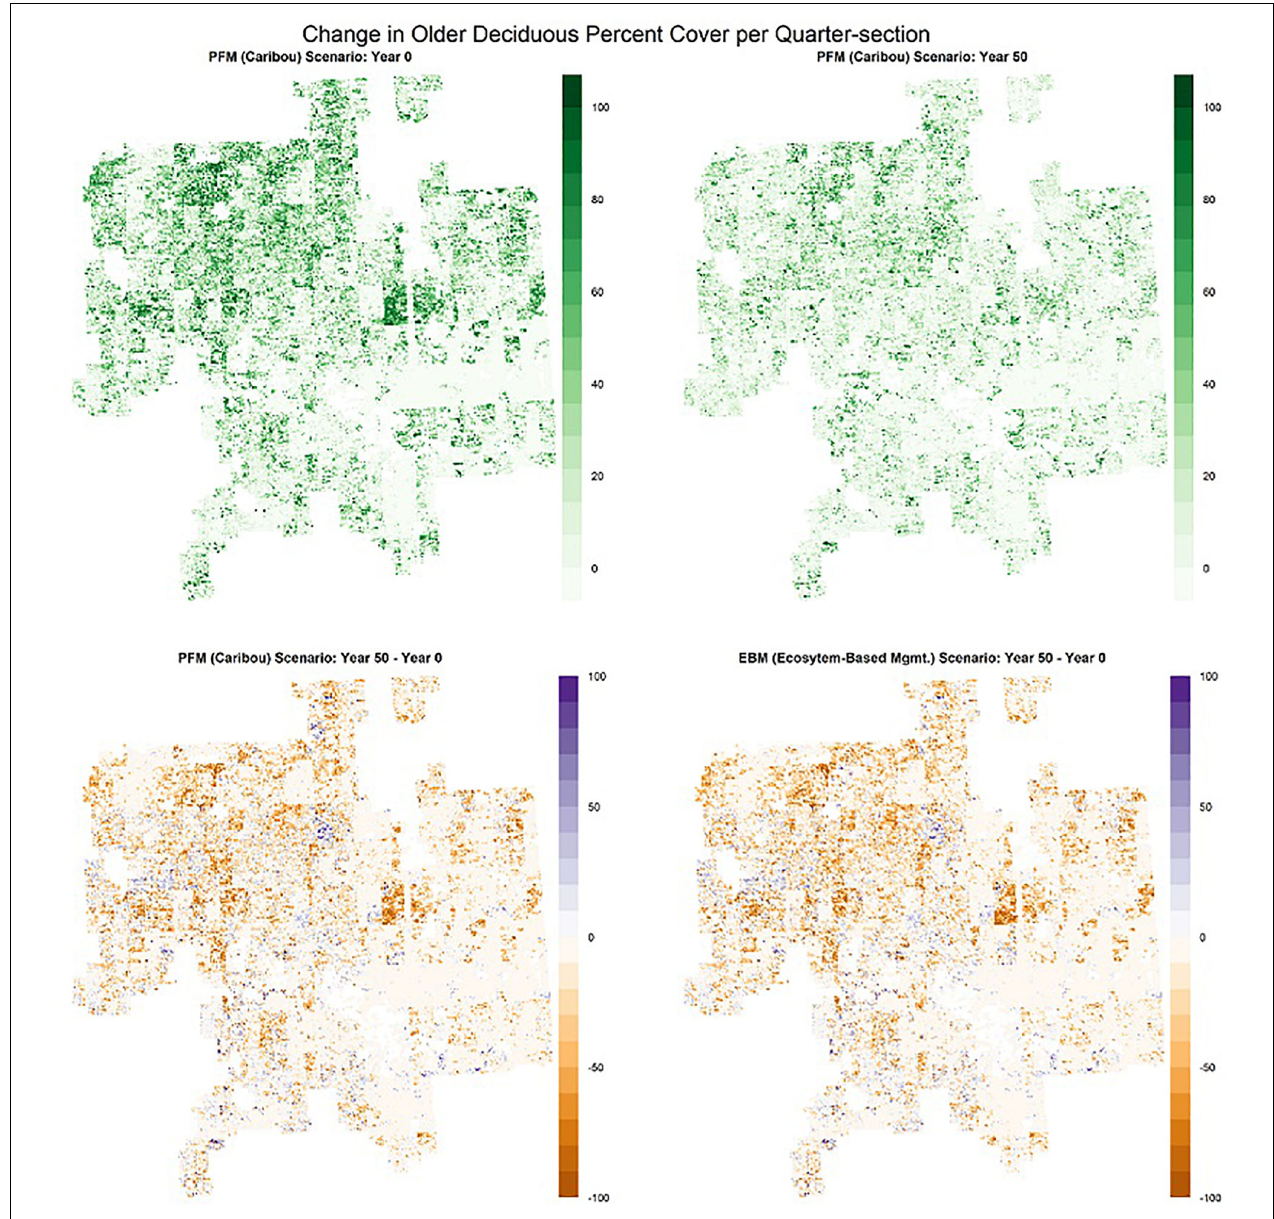
FIGURE 8 | Distribution of all deciduous forest stands > 60 years old, regardless of origin from fires or harvest, in the Al-Pac Forest Management Area (FMA): (1) mean percent cover per quarter-section by older deciduous forests in Year 0 of the Preferred Forest Management (PFM) scenario that included harvest deferral within caribou habitats (top left) ; (2) mean percent cover per quarter-section by older deciduous forests in Year 50 of the PFM scenario (top right) ; (3) change in mean percent cover per quarter-section by older deciduous forests over 50 years under the PFM scenario (bottom left) ; (4) change in mean percent cover per quarter-section by older deciduous forests over 50 years under the Ecosystem-Based Management/Natural Disturbance Model (EBM) scenario without harvest deferral (bottom right) . The amount of older deciduous forests in some areas with larger concentrations was strongly reduced over 50 years in both scenarios, but new forests > 60 years old developed from cutblocks harvested prior to Year